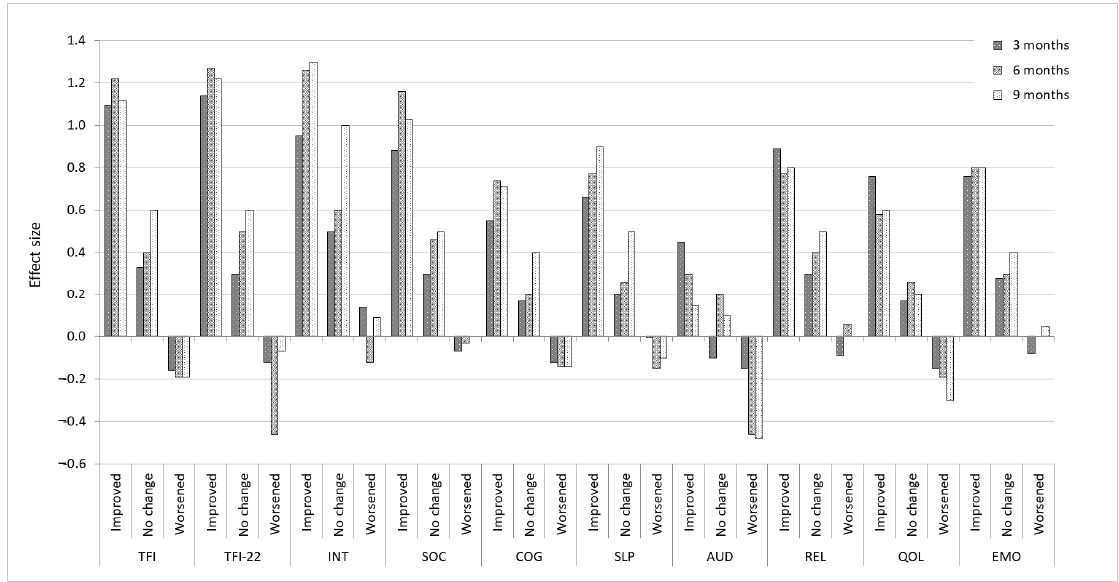
Figure 1. Effect sizes for TFI, TFI-22 global and subscales corresponding to three Clinical Global Im- pression categories (‘improved’, ‘no change’, ‘worsened’) at follow-up administrations. ES estimates are: ≥ 0.20 is a small effect, 0.5 is a medium effect, and ≥ 0.80 is a large effect